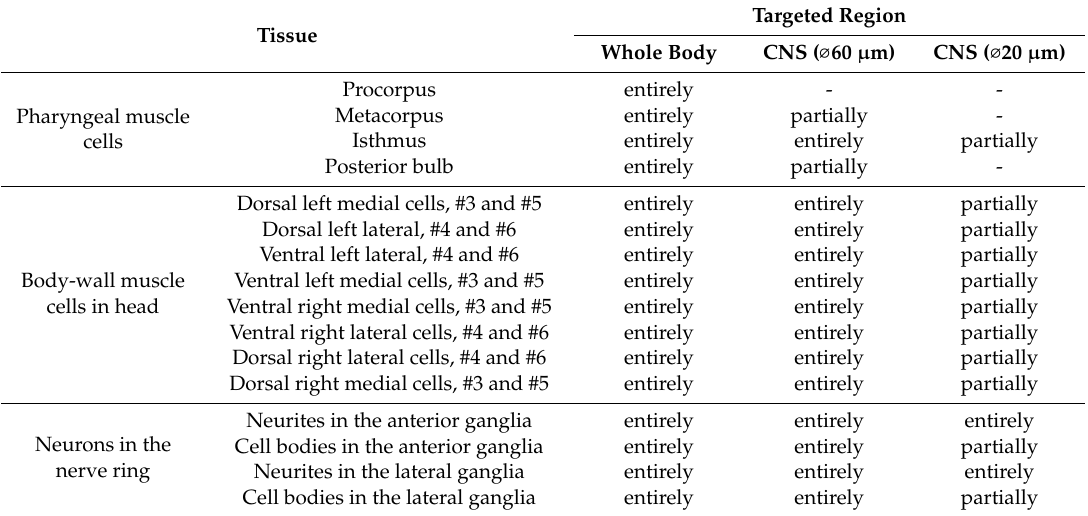
Figure 1. Schematic of the CNS-targeted irradiation of individual live C. elegans using a microfluidic chip. ( a ) Cross-sectional view of CNS-targeted irradiation of a live C. elegans enclosed in a microfluidic channel of a microfluidic chip. Anatomical structure of an individual C. elegans in the right panel was compiled with reference to a previous report [3]. ( b ) Schematic of a 300-µm, ultra-thin, ion-penetrable, wettable, microfluidic chip (Worm Sheet IR) enclosing live C. elegans individuals in the microfluidic channels. ( c ) Overhead view of the anterior body of an individual live C. elegans enclosed in a straight region (filled in blue) or the center of the nerve ring (CNS) in a ⌀ 20-µm micro-aperture region (filled